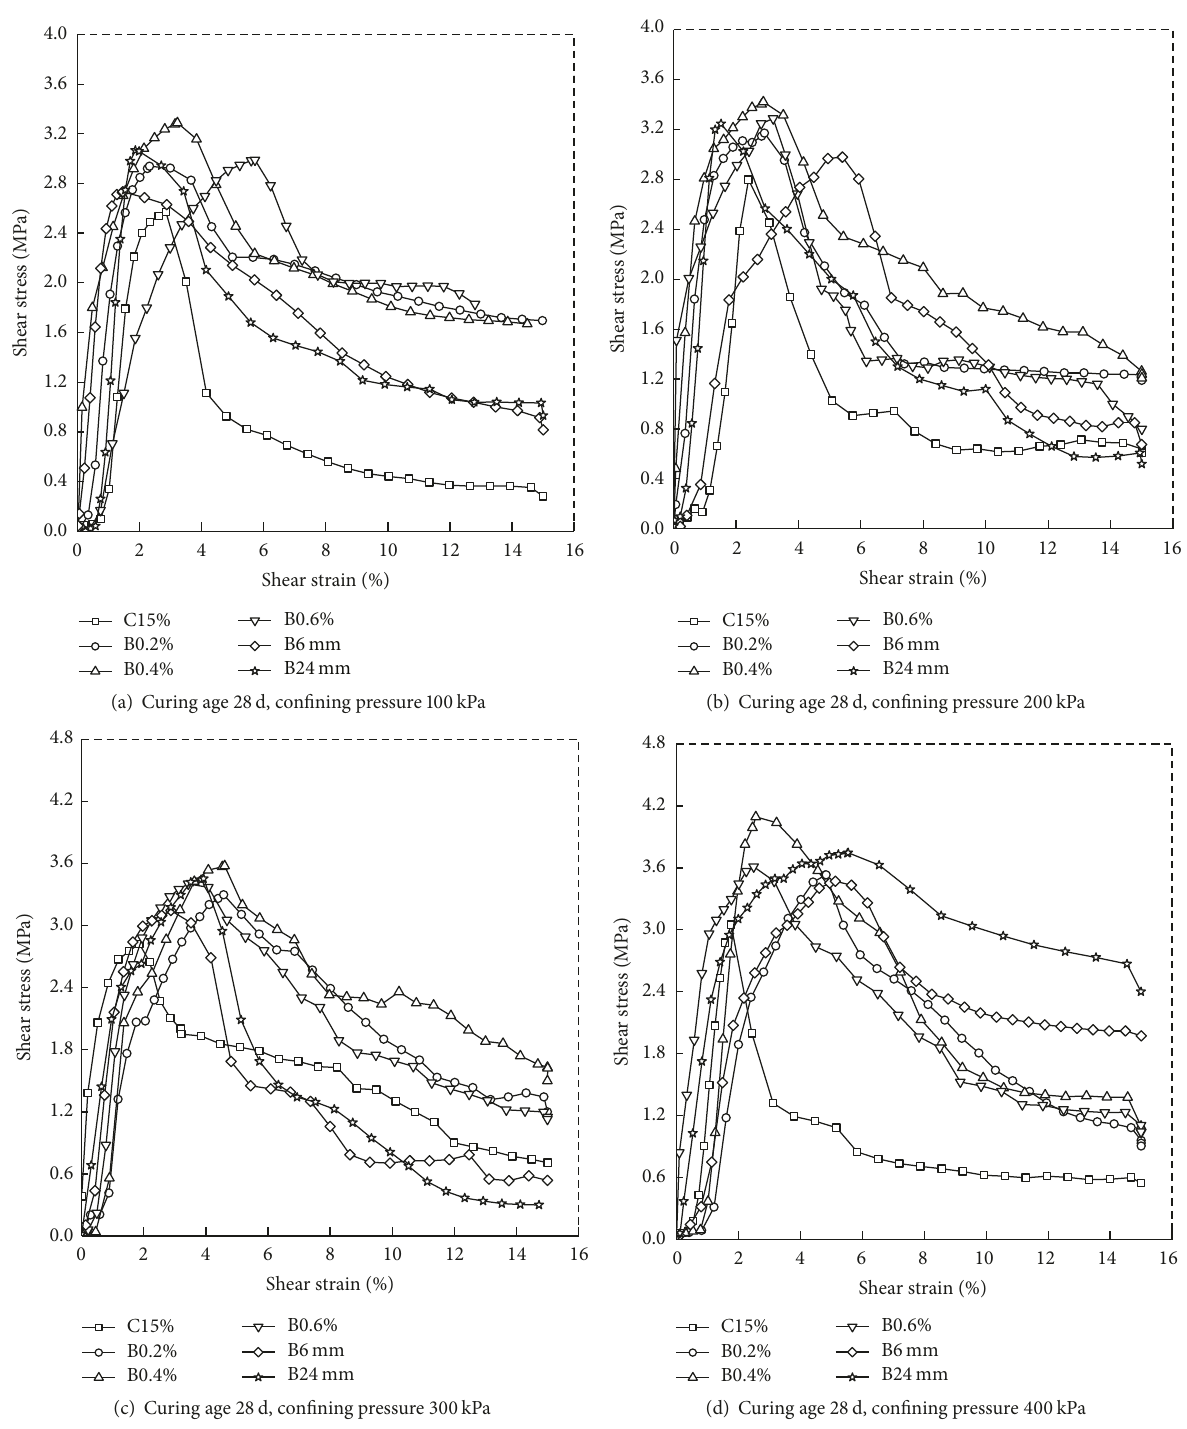
Figure 9: The curves of shear stress and shear strain after curing for 28